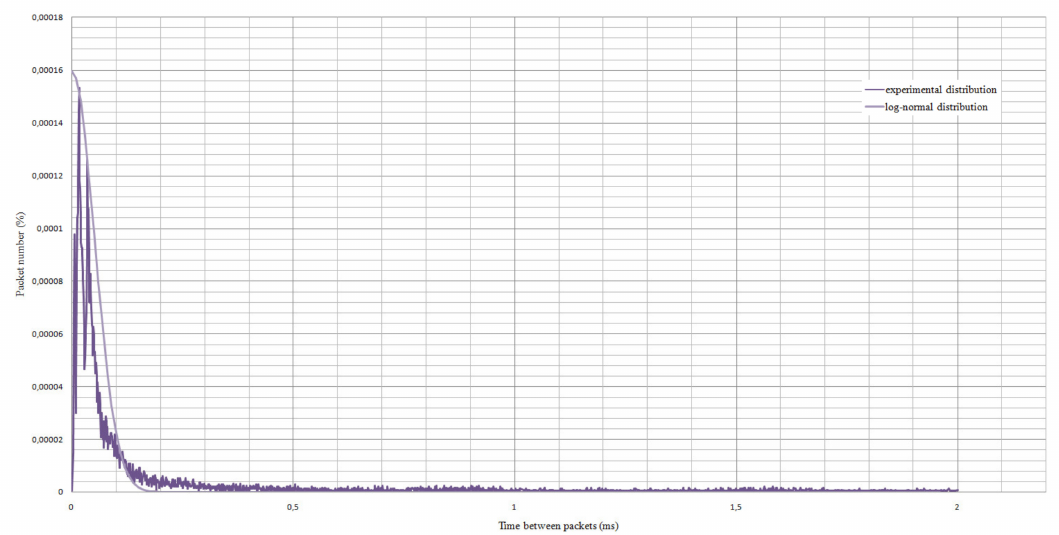
Figure 11. Comparison of the obtained results with the values obtained in the log-normal